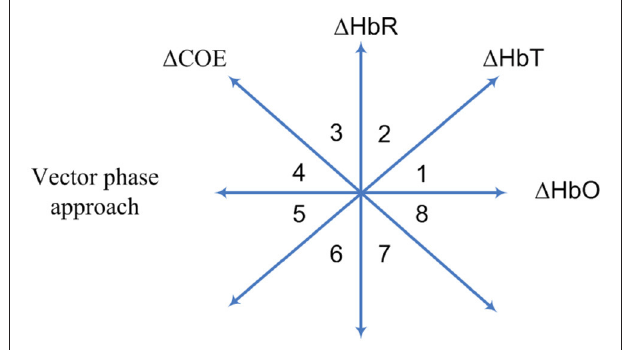
FIGURE 5 | Vector-phase diagram proposed by Kato (2003).